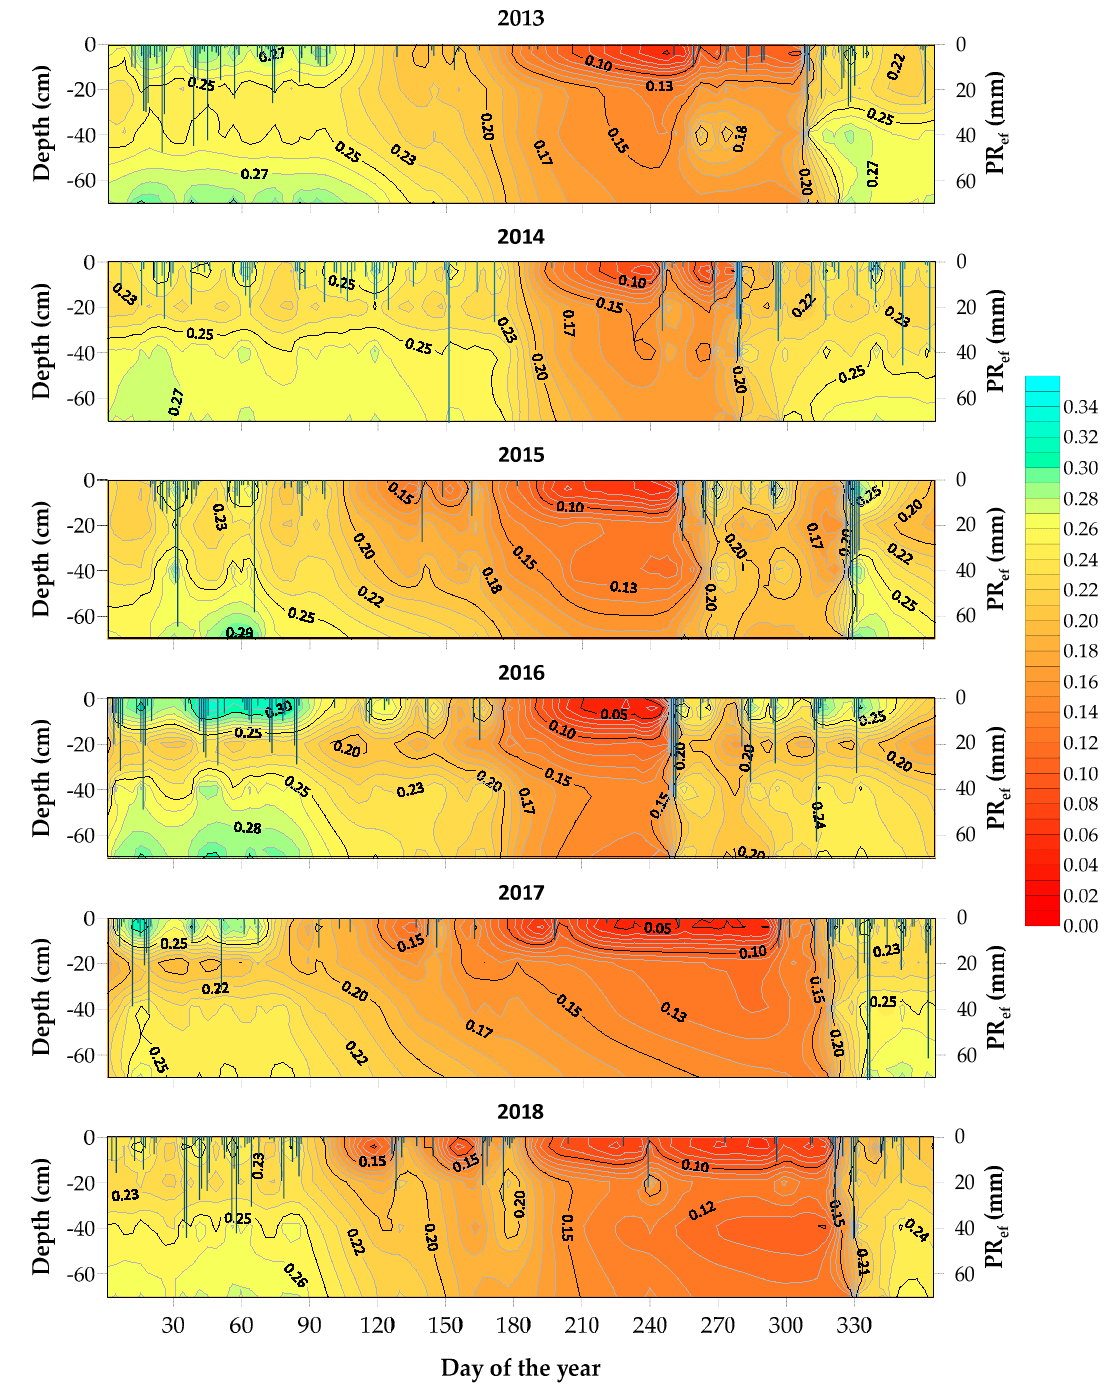
Figure 9. Changes in soil moisture SM profile in cm 3 /cm 3 based on daily values (left axis) and daily e ff ective precipitation PR ef (right axis), for the years 2013–2018.